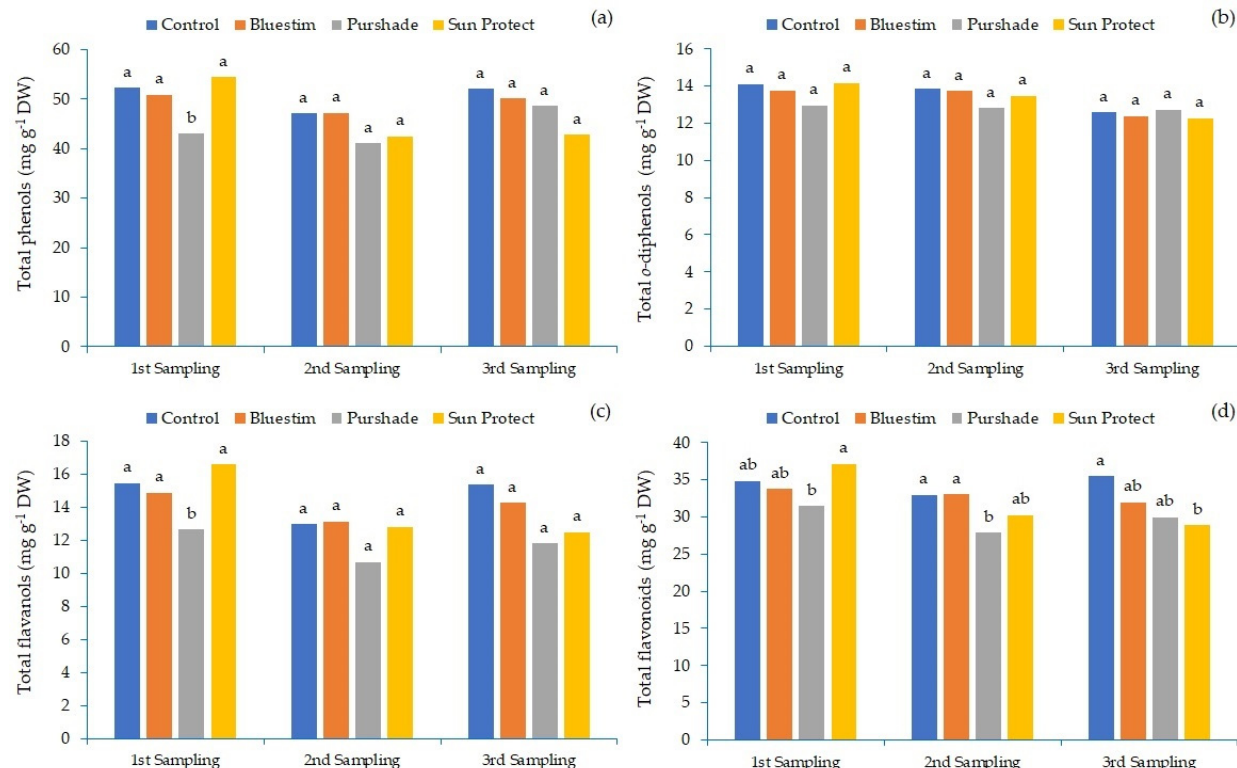
Figure 2. Effects of the alleviating products on the total phenolic compound concentration, ( a ) total phenols, mg equiv. gallic acid g − 1 DW, ( b ) total o -diphenols, mg equiv. caffeic acid g − 1 DW, ( c ) total flavanols, mg equiv. catechin g − 1 DW and ( d ) total flavonoids, mg equiv. catechin g − 1 DW, of the kiwifruit leaves during the first (on August 7th), second (on August 20th), and third (on September 21st) sampling events. Different letters above each column under the same sampling event denote statistically significant differences among the treatments according to Tukey’s HSD multiple range test at α = 0.05.